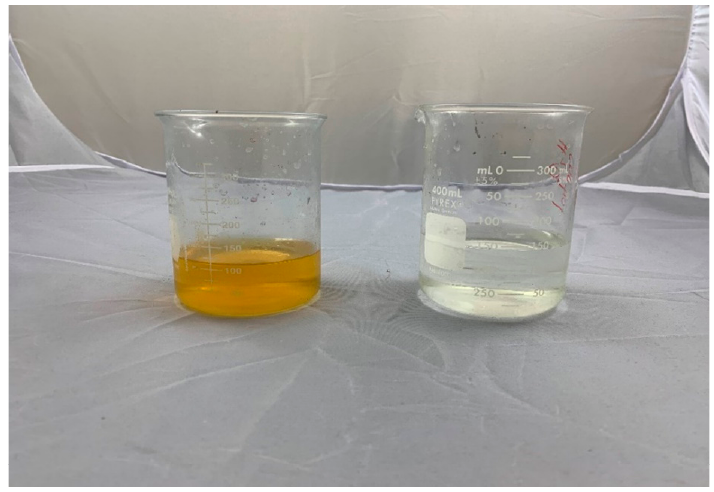
Figure 7. Net water release over time during filtration following flocculation and degradation at 75 °C for 5 days with poly(TMAEMC) and poly(PLA 4 ChMA).